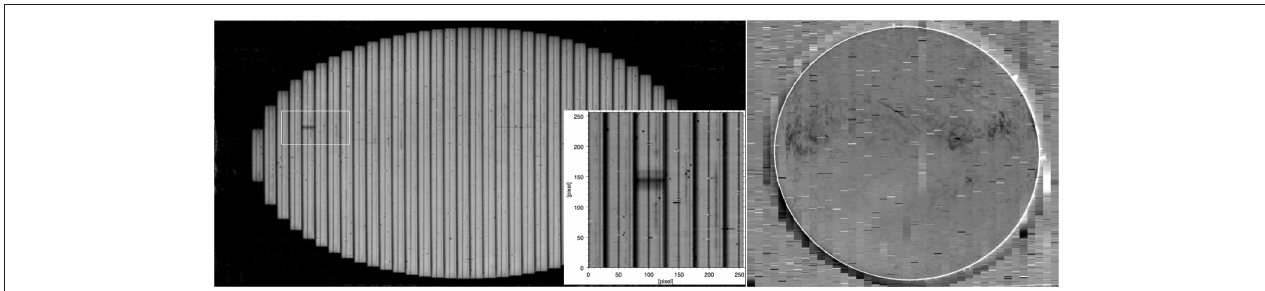
FIGURE 2 | Left: 34-slit spectra of the full Sun obtained with the mxSPEC proof-of-concept instrument. Each vertical slice in the image is a horizontally dispersed spectrum. The 2048 2048 image was rescaled to a 2408 1024 image to better display the slit spectra. Close-up of spectra of a sunspot in the rectangular box in × × the full-disk spectral image are shown in the insert. Right: He I 1083 nm line core image constructed from a full-disk scan. The black and white short horizontal lines are data reduction artifacts due to defective